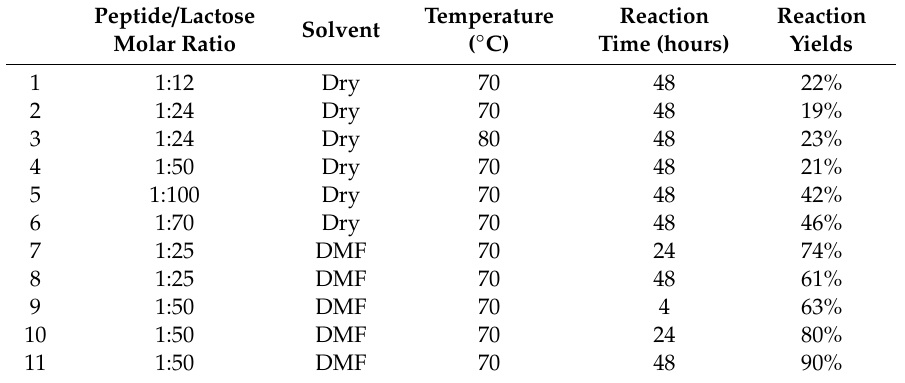
Table 8. Reaction conditions tested in the optimization of the site-specific peptide lactosylation. Peptide / Lactose Solvent ( ◦ C) Molar Ratio